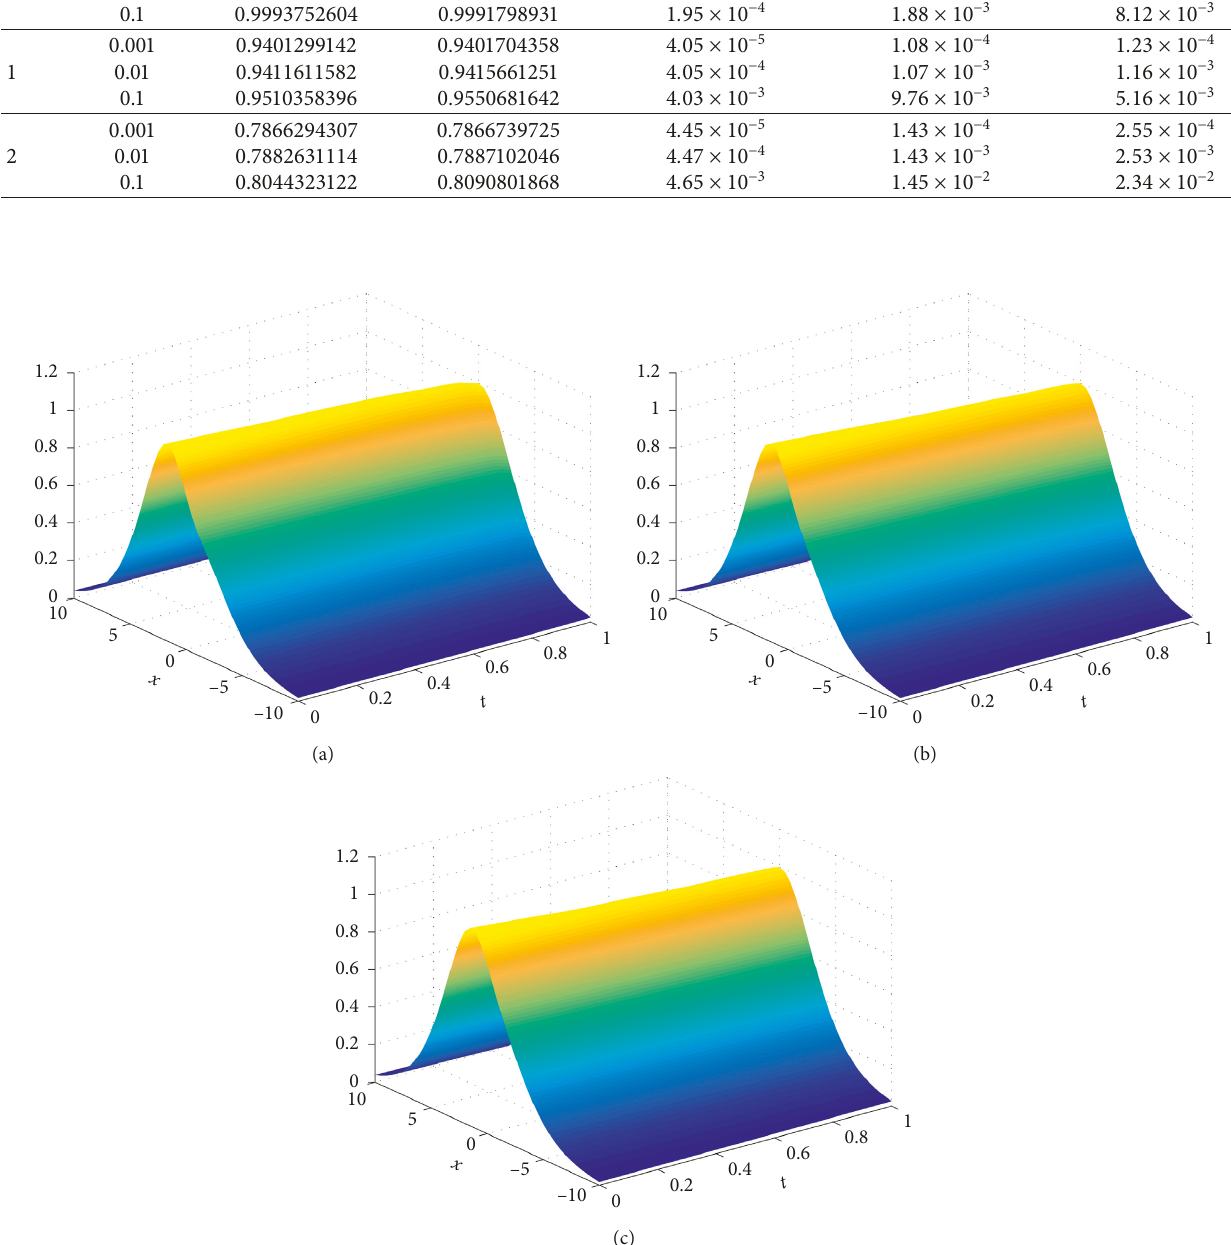
Figure 4: Approximate solution: (a) 􏽥 u ( x,t, α � 0 . 3 ) ; (b) 􏽥 u ( x,t, α � 0 . 6 ) ; (c) 􏽥 u ( x,t, α � 0 . 9 )